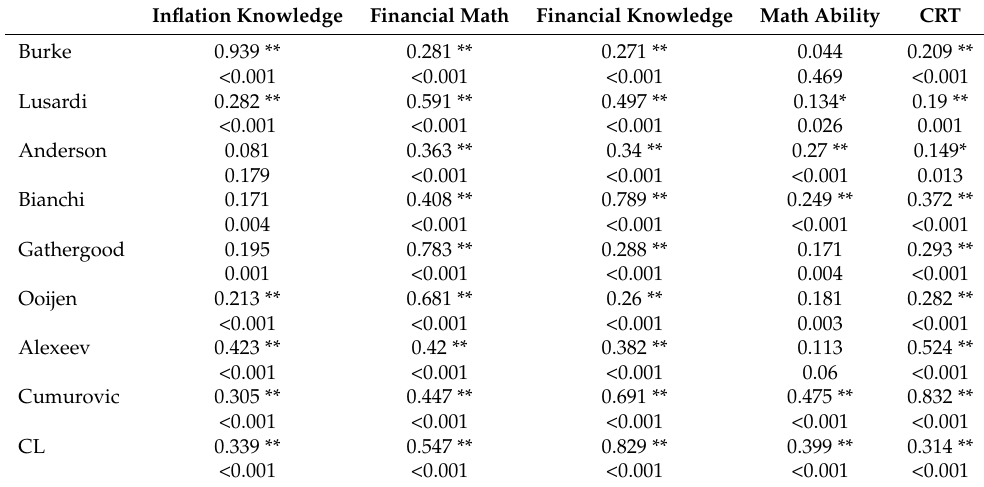
Table A1. Robustness check: partial correlations of the financial literacy measures with the four subtopics and cognitive reflection test (CRT), controlling for the survey